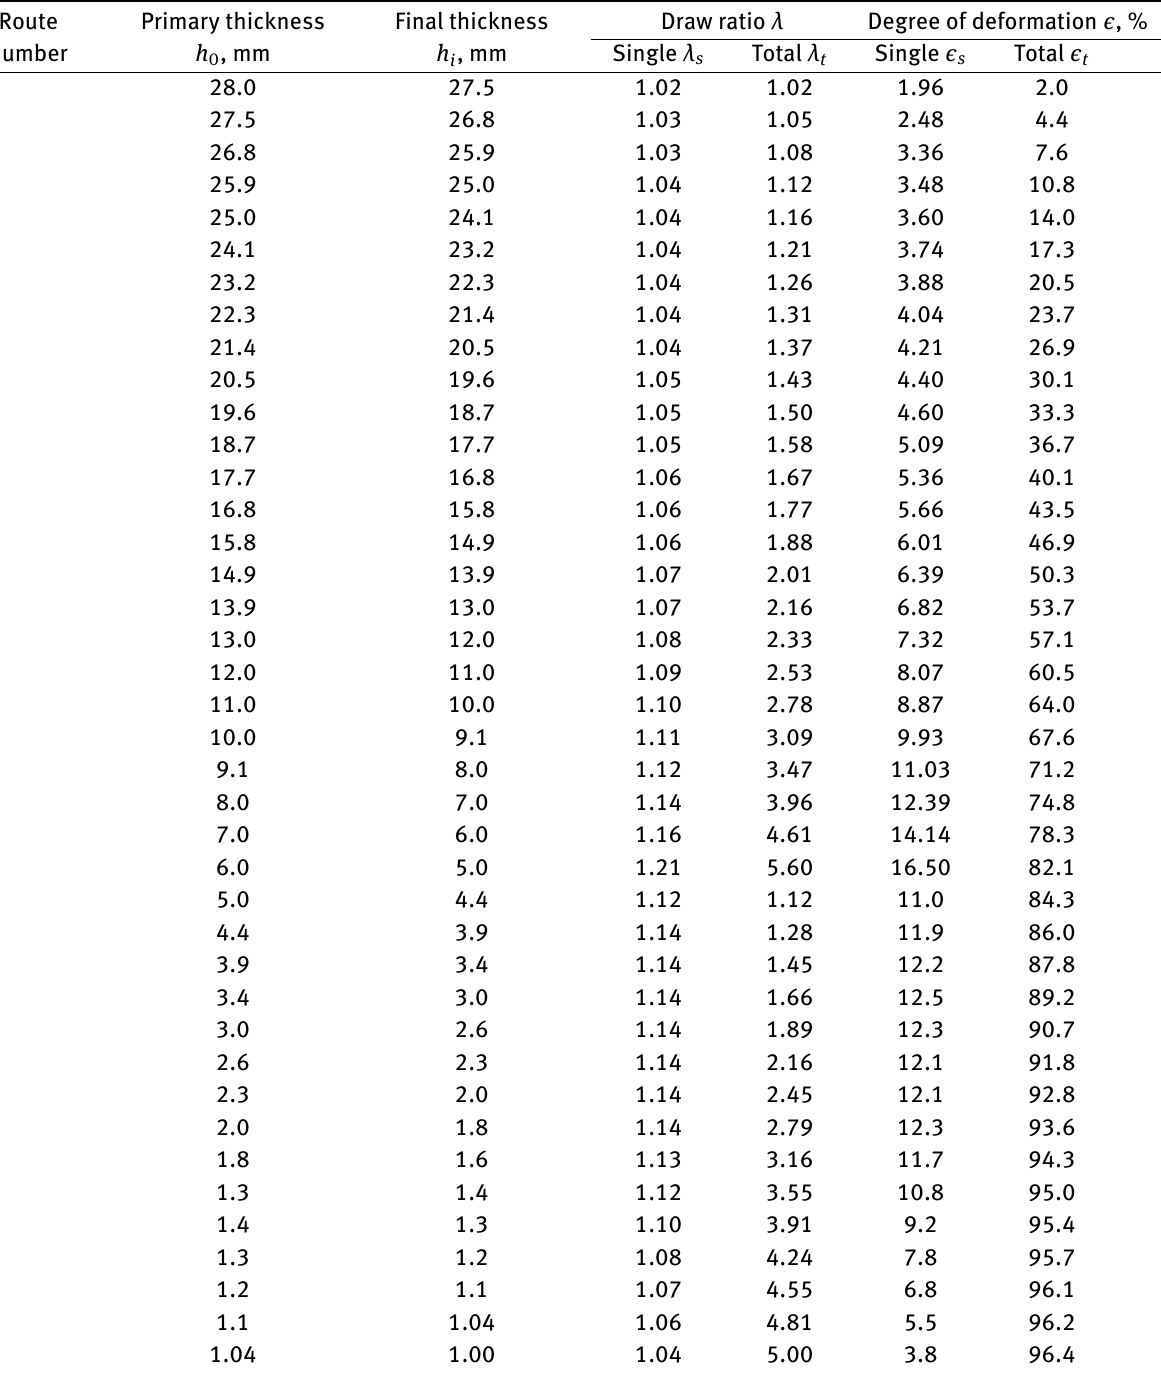
Table 1: Route of rolling all investigated alloys